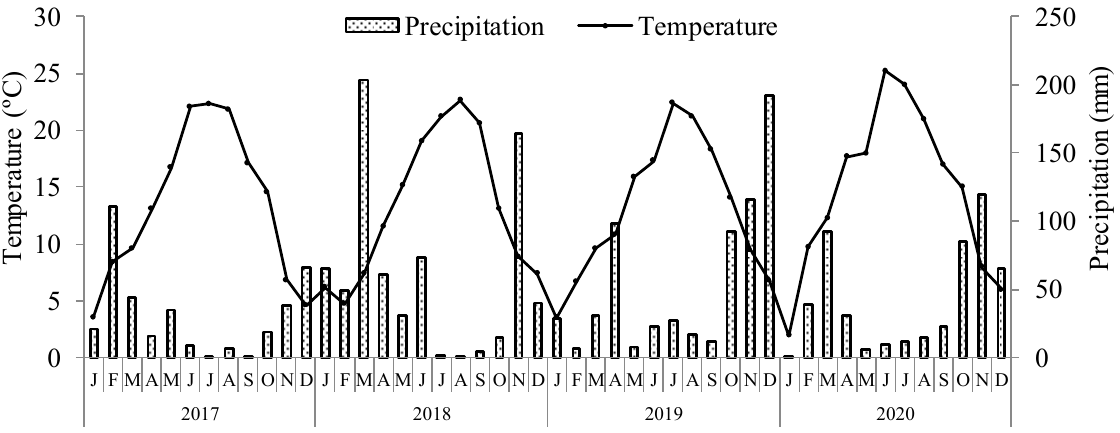
Figure 1. Monthly precipitation and average monthly temperature during the experimental period in Mirandela, Northeast Portugal. Table 1. Selected properties (average ± standard deviation) of the 0–20 cm soil layer. Soil Properties